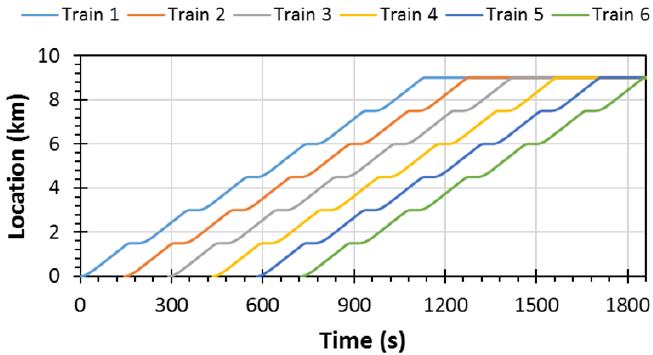
Figure 3. Diagrams of six trains running on a single track consisting of seven passenger stations.